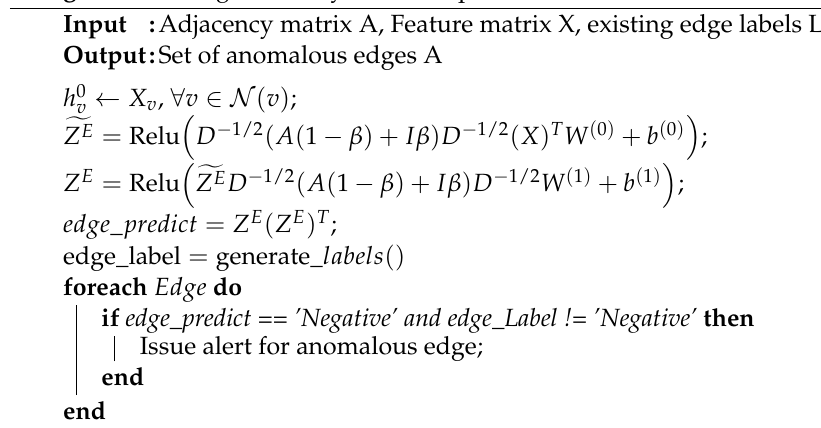
Algorithm 2: Edge anomaly detection